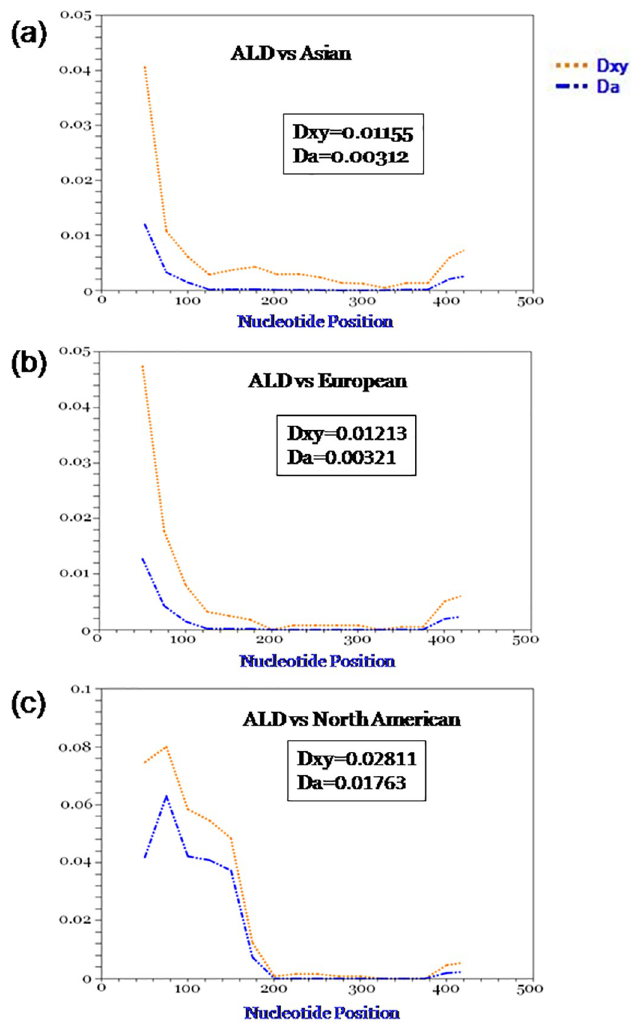
Fig 7. Genetic divergence between ALD and other mallard population. Dxy denotes average number of nucleotide substitution per site and Da denotes number of net nucleotide substitution per site.